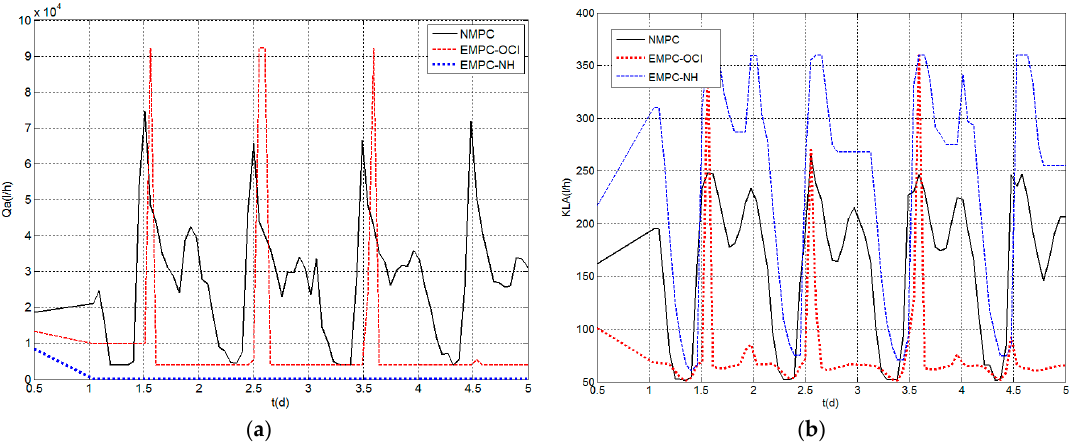
Figure 7. Control signals applied to the BSM1 plant operating under NMPC and EMPC controllers.